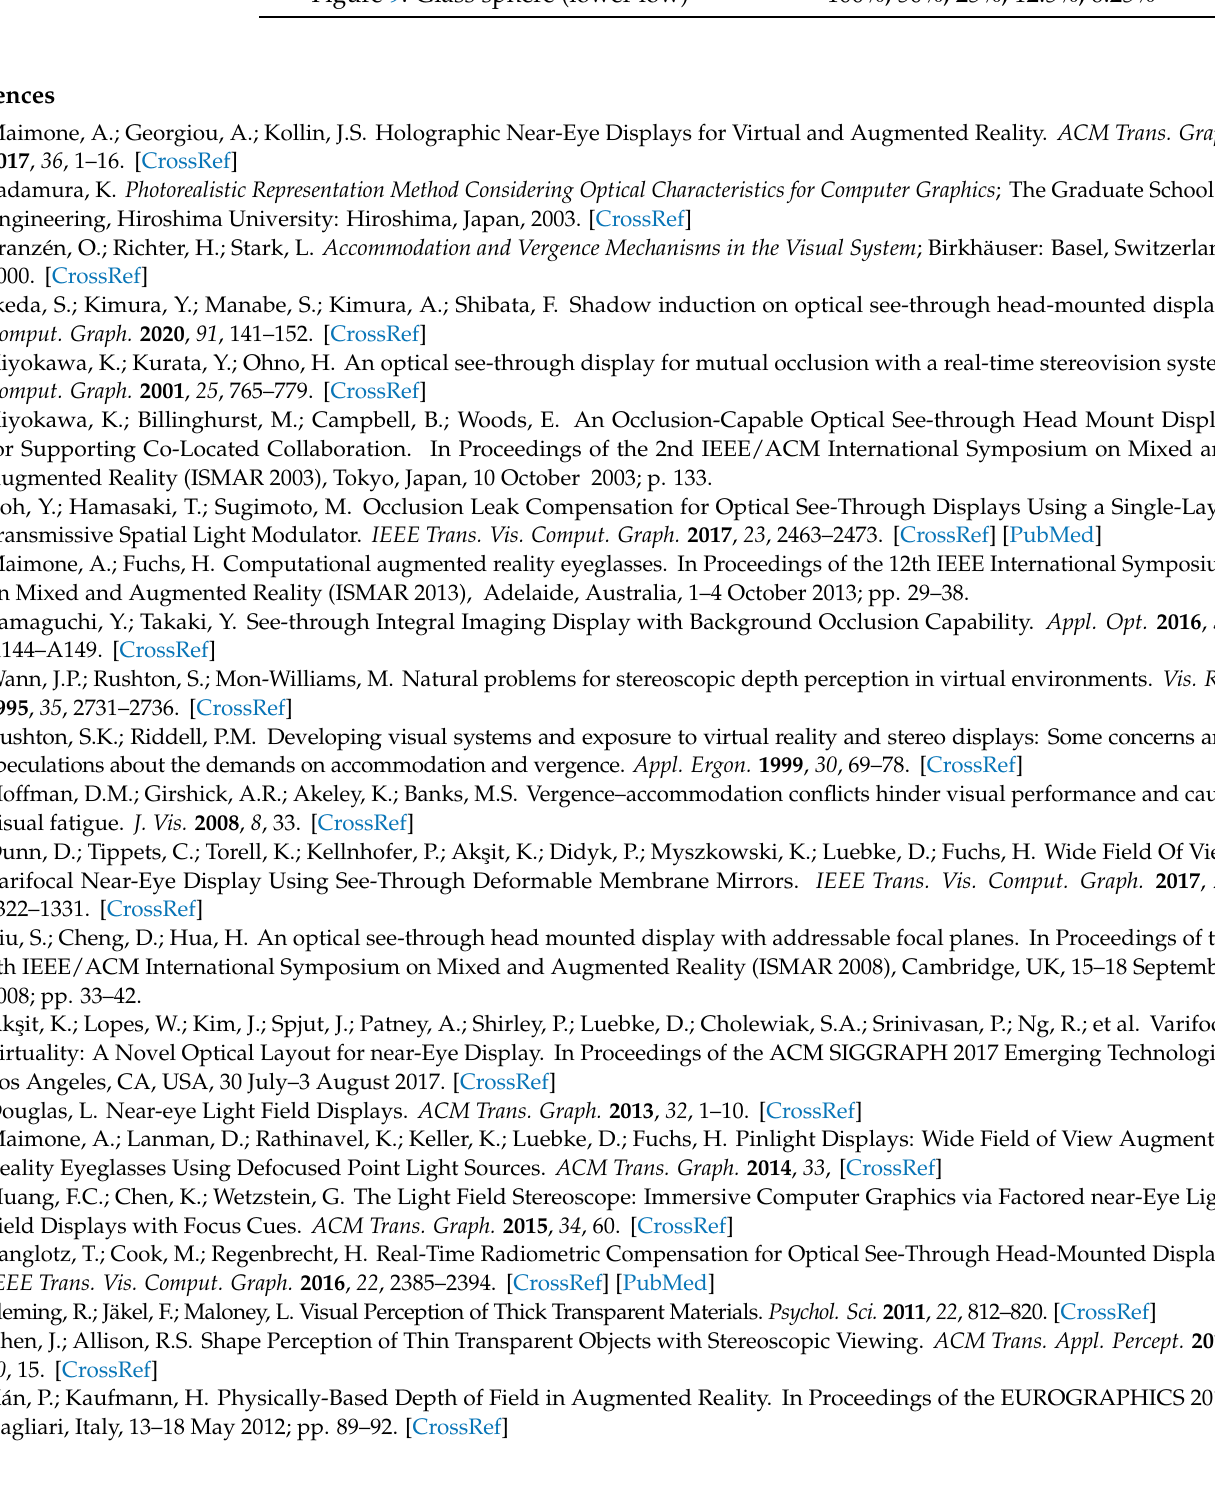
Table A1. Neutral-density (ND) filters used for image acquisitions. Virtual Object Transmittance Ratios of ND Filter(s) Figure 3A: Glass sphere 100% (no filter) Figure 3B: Diamond 100%, 50%, 25%, 12.5% Figure 9: Glass sphere (middle low) 100%, 50%, 25%, 12.5%, 6.25% Figure 9: Glass sphere (lower low) 100%, 50%, 25%, 12.5%,